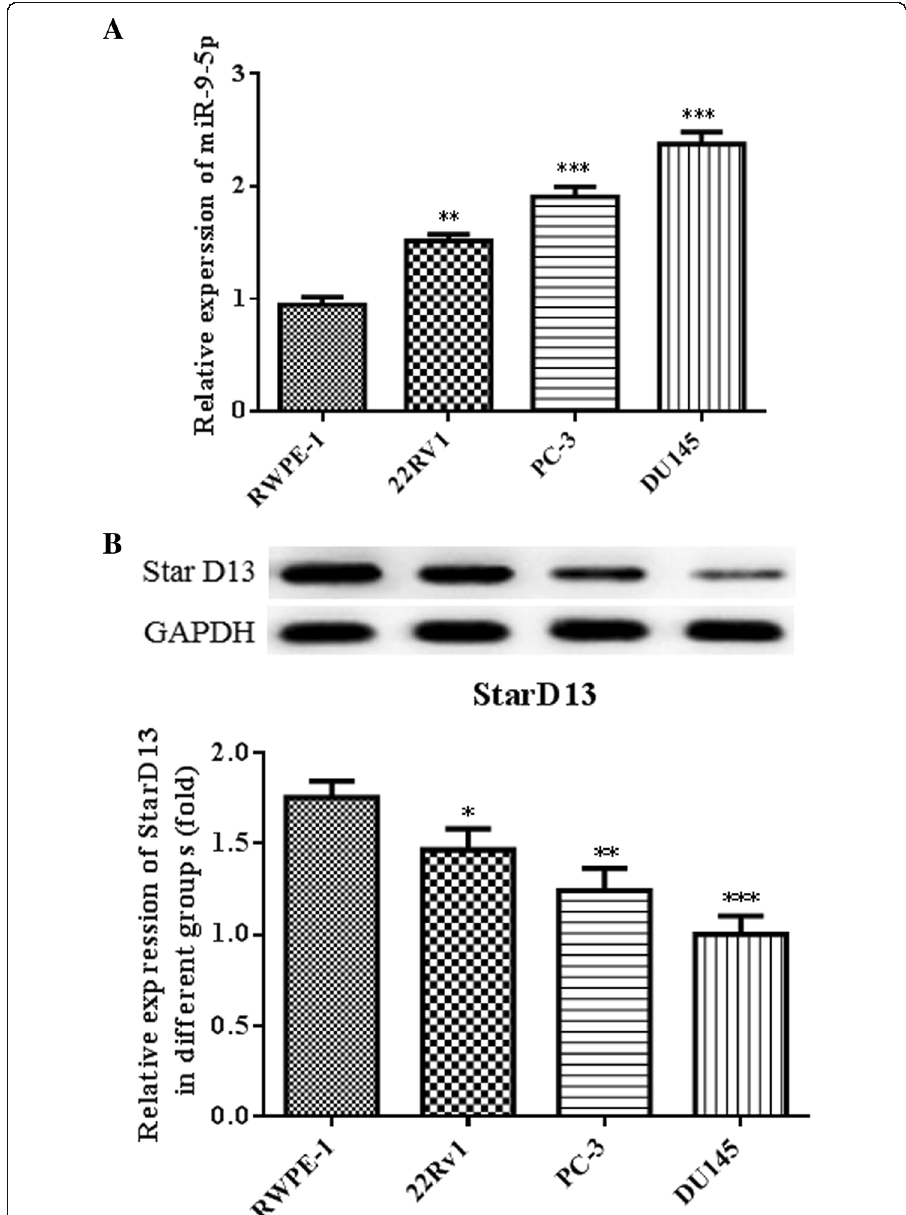
in RWPE-1, 22RV1, LAPC4 and DU145 cells were assessed via western blot. * p <0.05; ** p <0.01; *** p <0.001